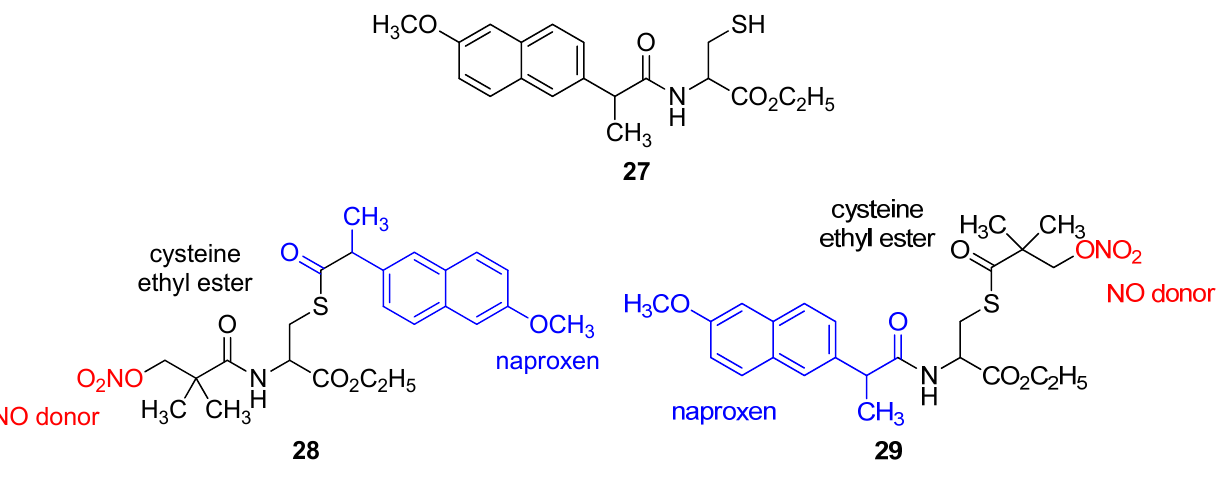
Figure 19. Triple hybrid of naproxen, cysteine ethyl ester, and nitrooxypivaloic acid ( 28 and 29 ). Hybrid intermediate of naproxen and cysteine ( 27